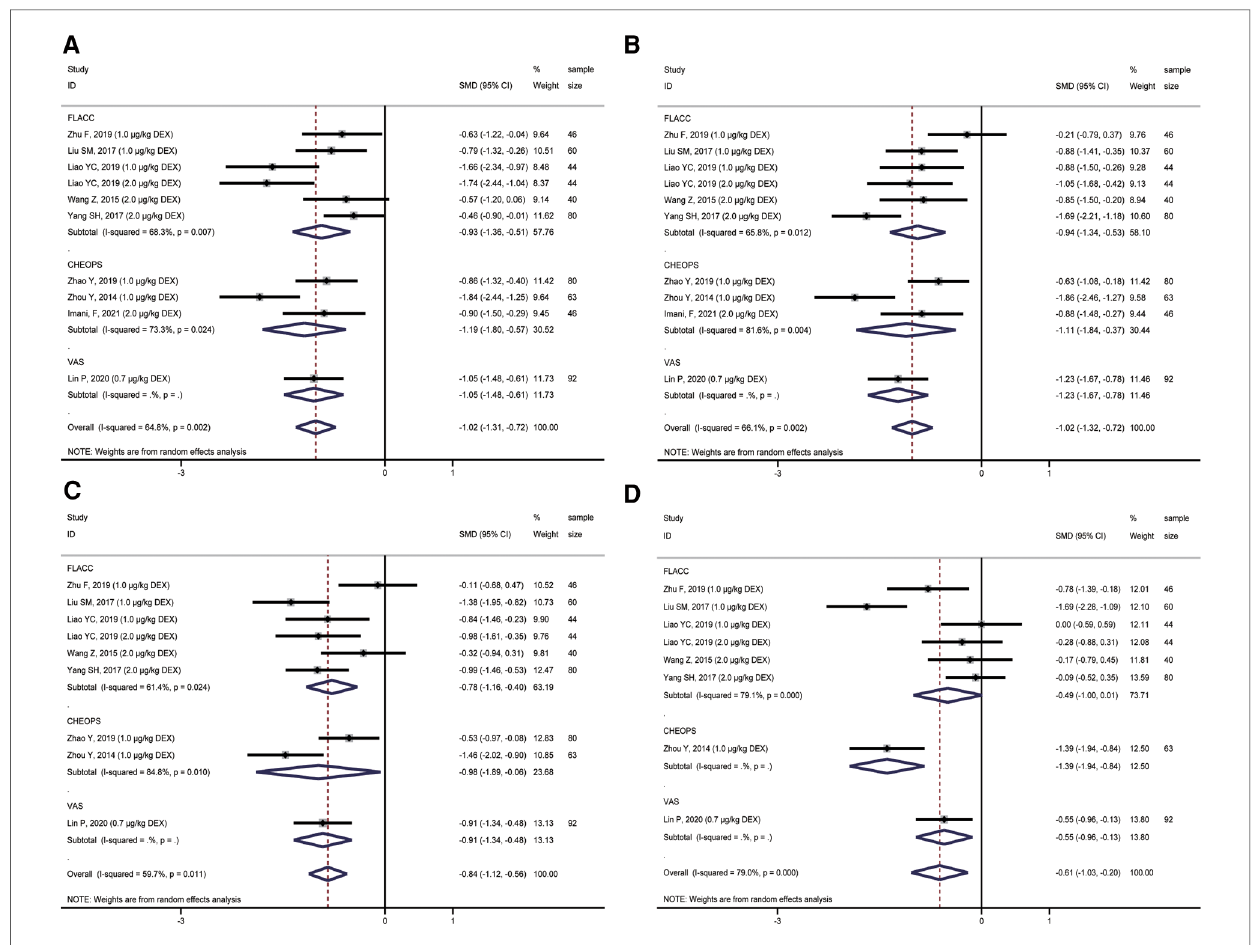
FIGURE 3 Forest plot of comparison of combined group and control group: ( A ) Pain score at 2 h (T 1 ); ( B ) Pain score at 4 h (T 2 ); ( C ) Pain score at 8 h (T 3 ); ( D ) Pain score at 12 h (T 4